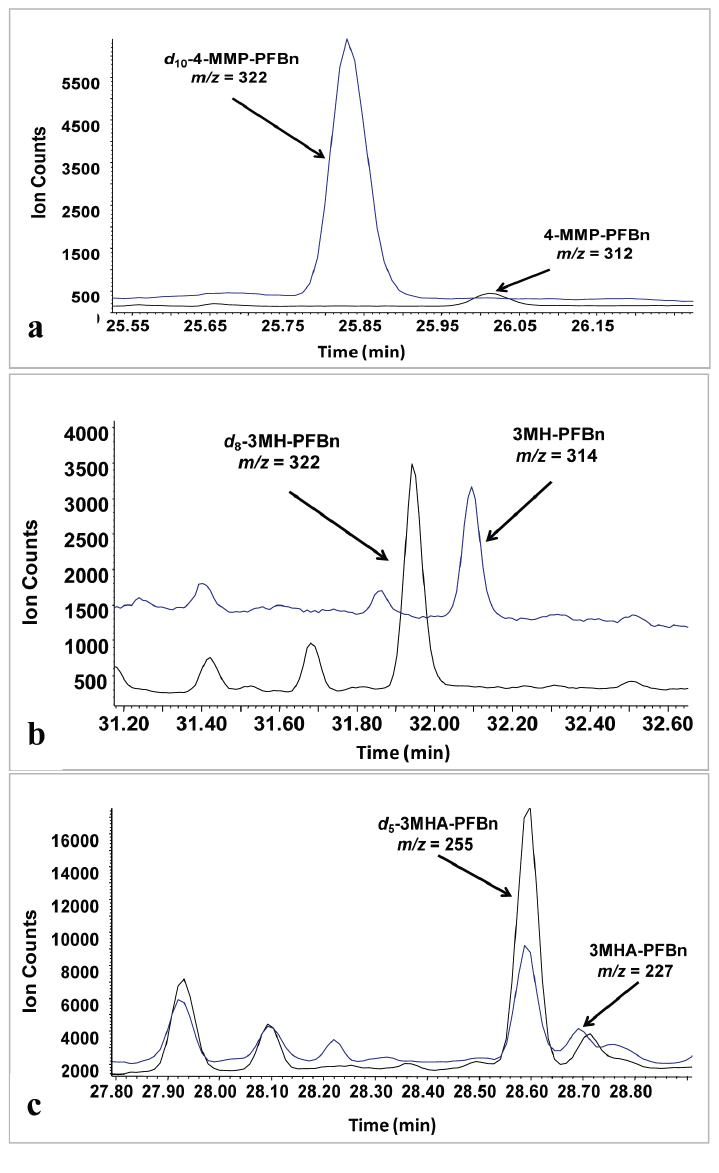
Figure 1. Typical chromatogram obtained in selective ion monitoring (SIM) mode: ( a ) White wine spiked with 10 ng/L 4-MMP and 540 ng/L d 10 -4-MMP; ( b ) White wine spiked with 25 ng/L 3-MH and 440 ng/L d 8 -3-MH; ( c ) White wine spiked with 60 ng/L 3-MHA and 400 ng/L d 5